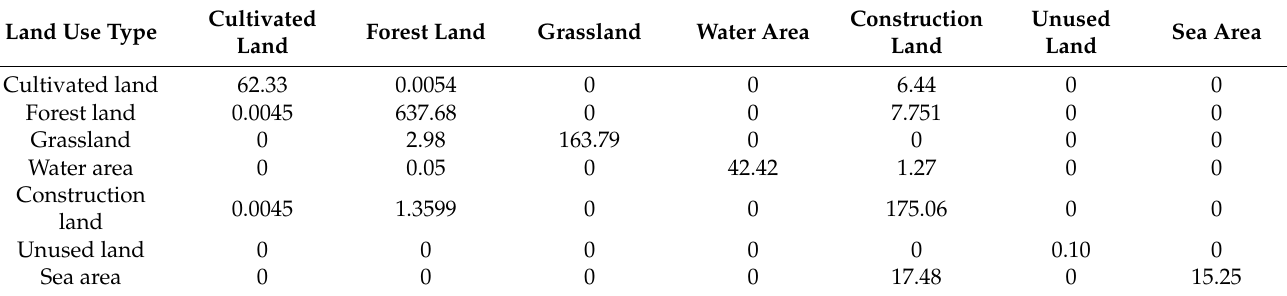
Table 5. Land use conversion matrix, 1990–2000 (km 2 ).